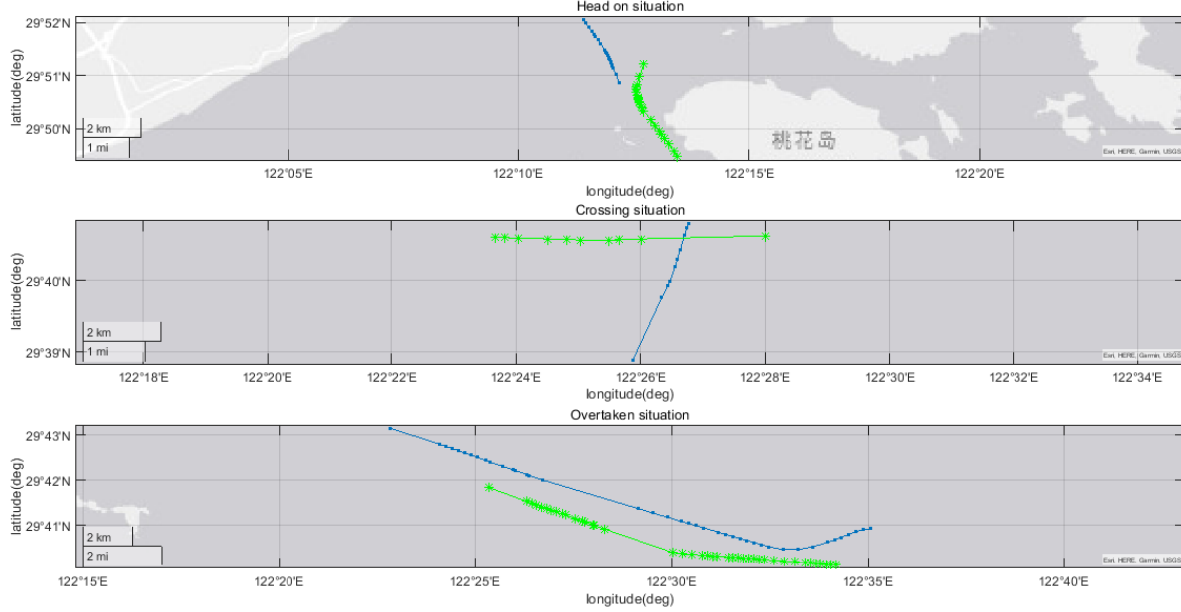
Figure 8. Identification results of pairwise encounters.